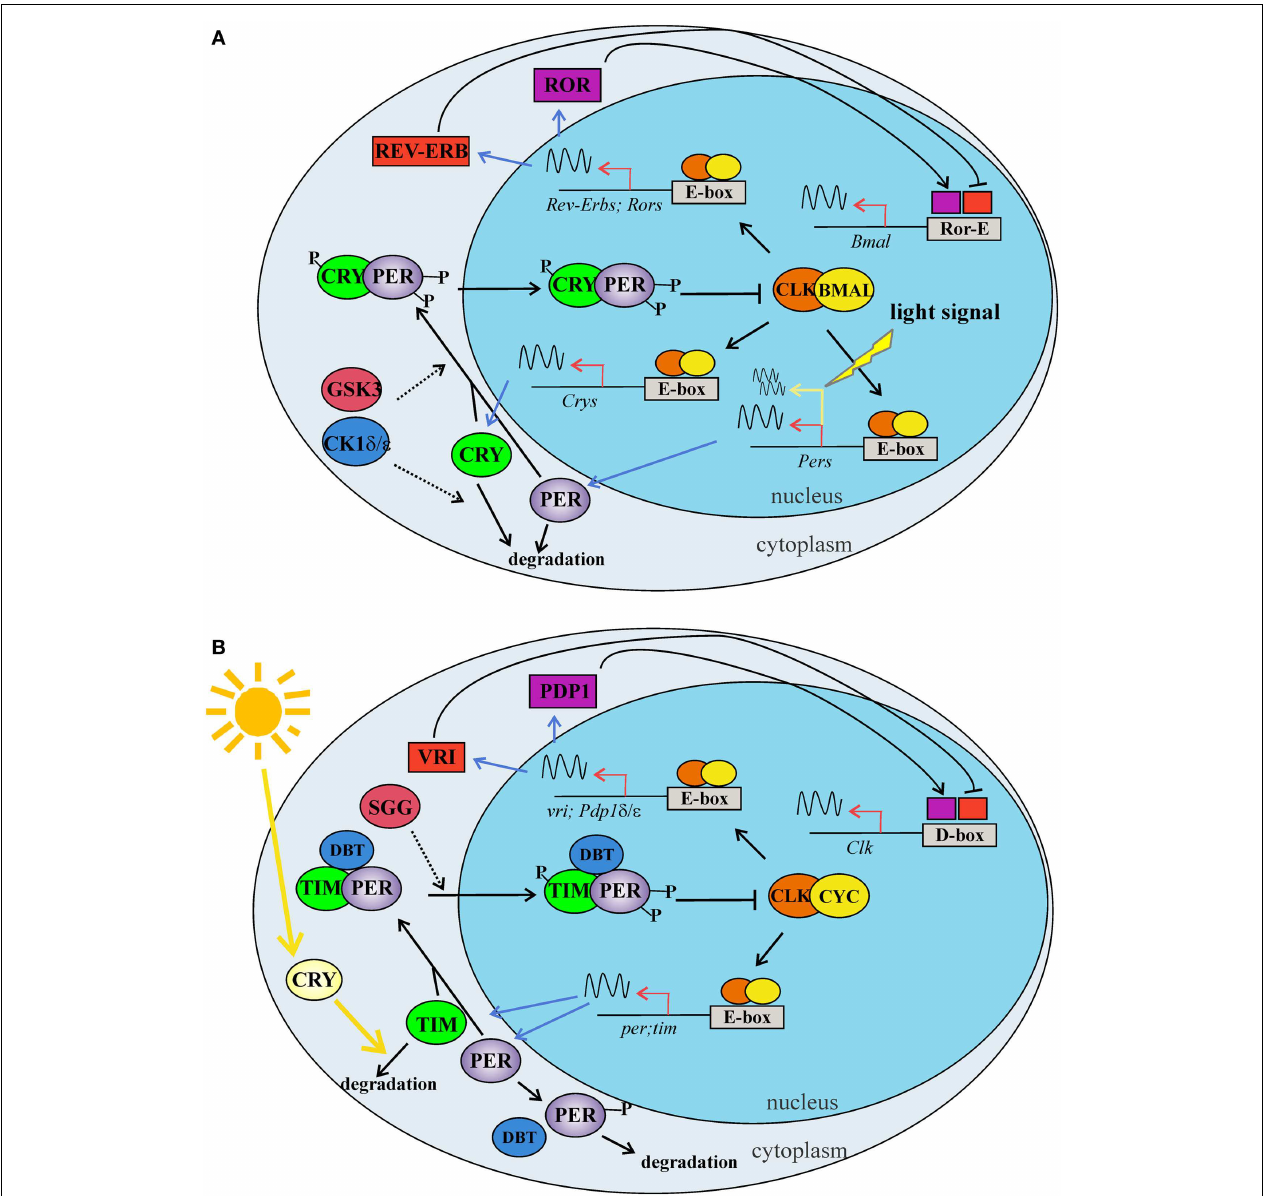
andTIM proteins interact in a complex, enter into the nucleus, and inhibit the CLK-CYC activity. A secondTTL modulates Clk expression: CLK-CYC dimer induces the transcription of vri and Pdp1 δ / ε genes.VRI and PDP1 δ / ε compete for the same element (D-box) in the Clk promoter,